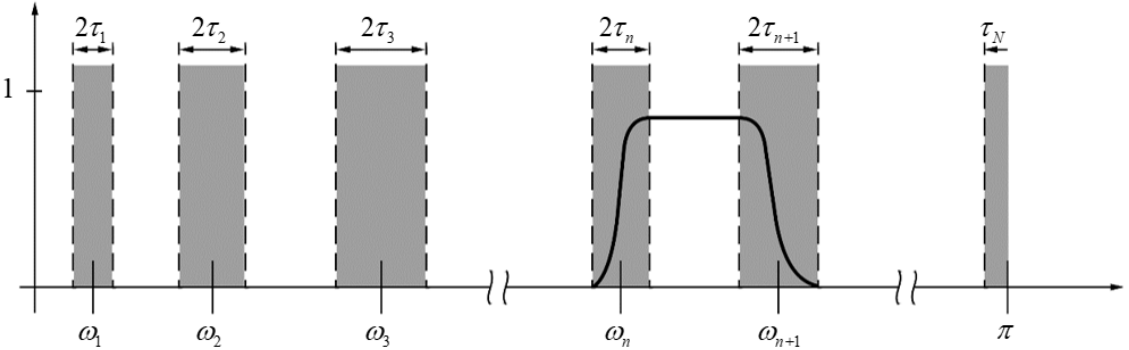
Figure 1. Fourier spectrum segmentation.